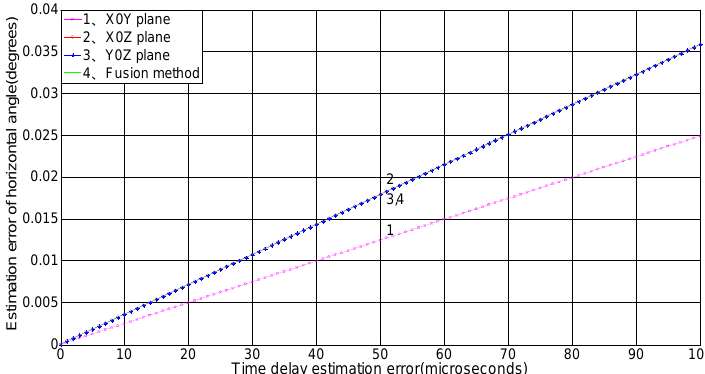
Figure 6. Relationship between the time-delay estimation error and horizontal angle measurement